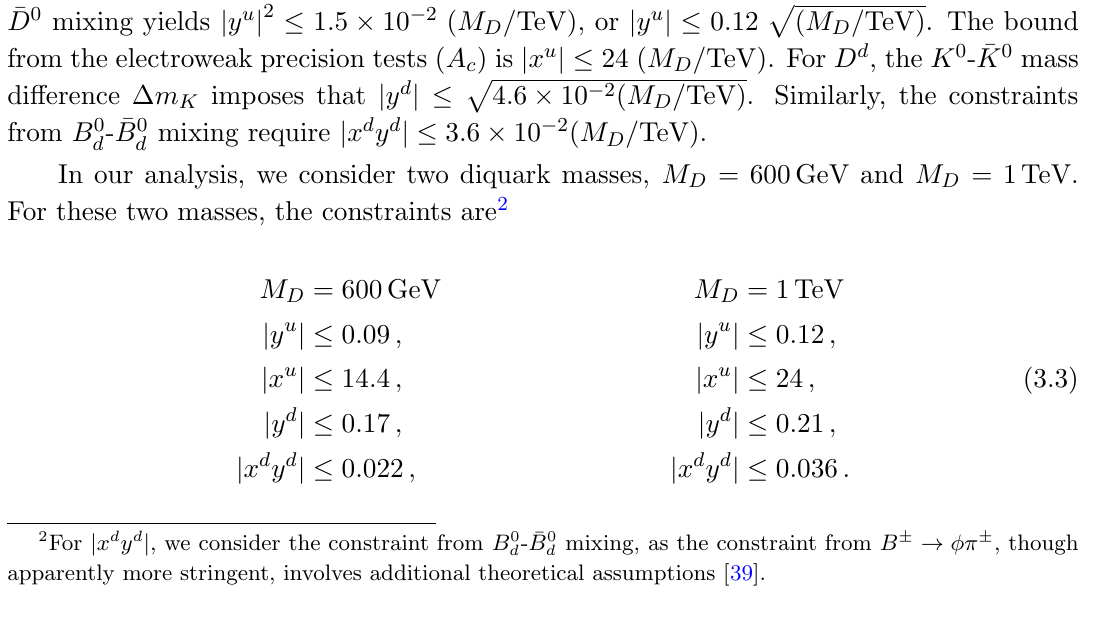
Table 2 . Bounds in units of M